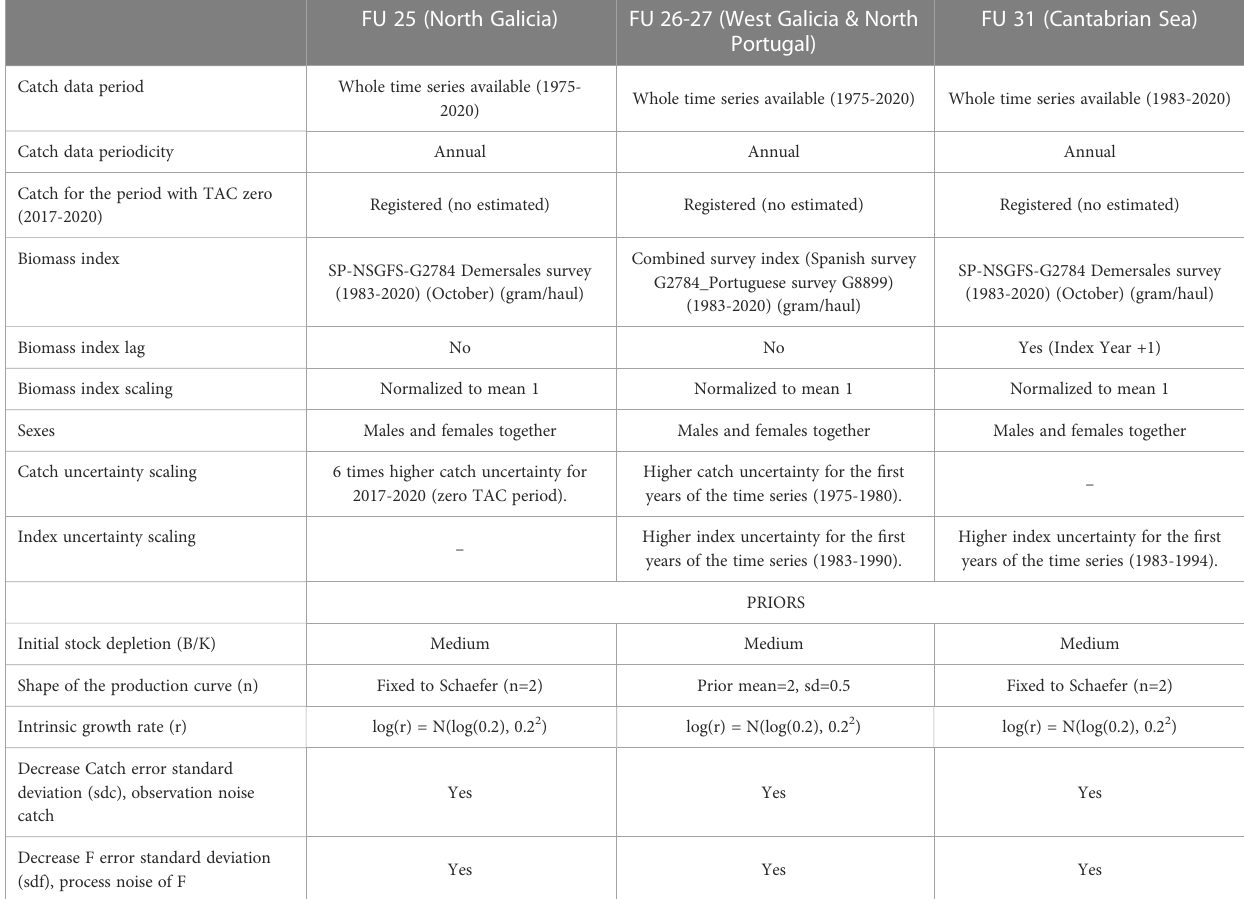
TABLE 1 Input data, settings and priors used for the SPiCT models of the three Functional